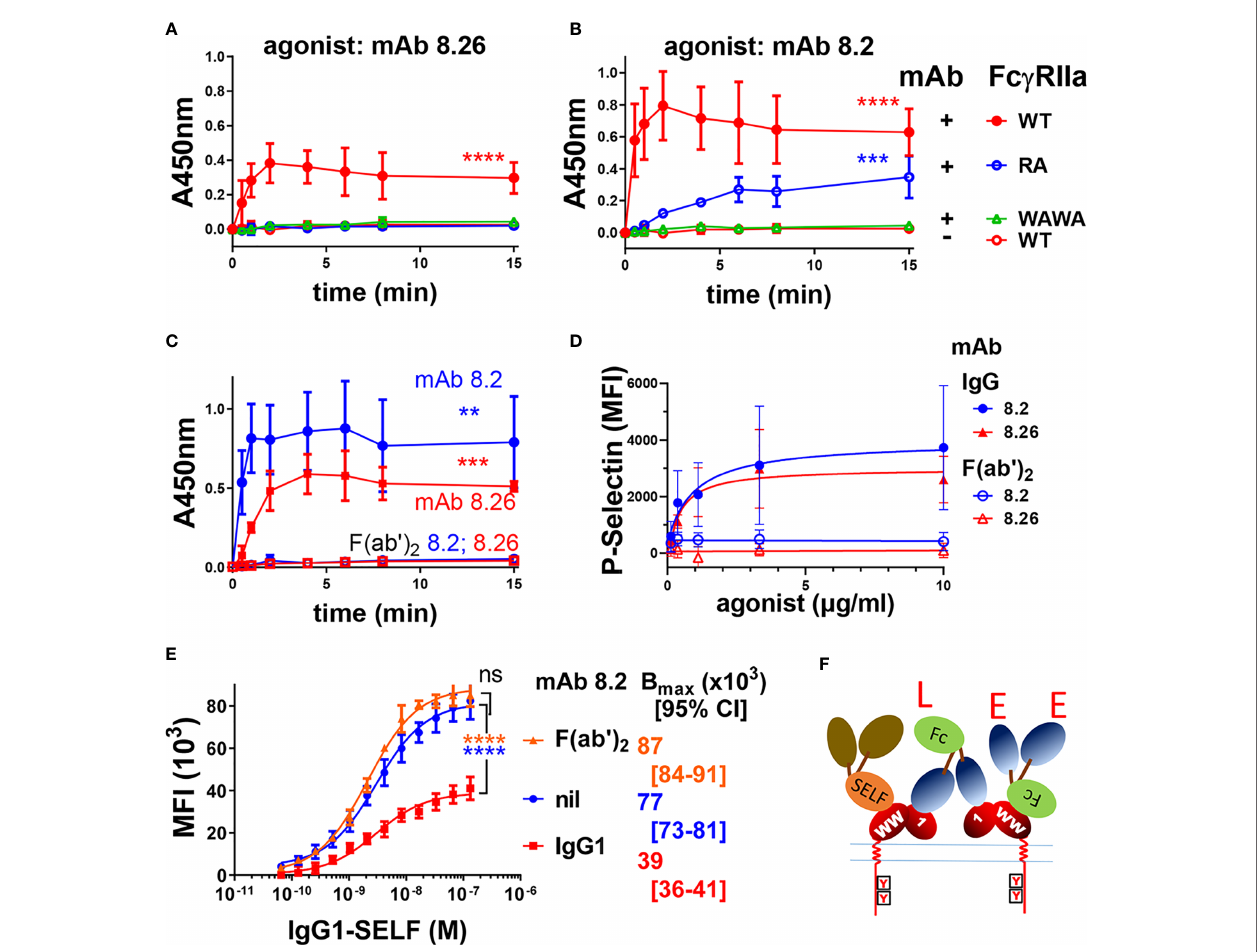
FIGURE 4 | Fc g RIIa activation by anti-receptor mAbs requires both Fc : Fc g R binding function and an intact epitope with arginine at position 55. Intact mAbs induce receptor phosphorylation (A, B) of IIA1.6 cells expressing Fc g RIIa-WT, the Fc-binding inactive mutant Fc g RIIa-WAWA or the epitope inactive Fc g RIIa-RA (R55A) as indicated, were untreated (nil mAb) or stimulated with the intact mAbs (A) 8.26 or (B) 8.2. At the indicated times cell lysates were prepared and mAb IV-3 captured phospho-proteins were detected in the Fc g RIIa phosphorylation assay using with mAb 4.G10-biotin (n = 3 ± SD). (C) F(ab ’ ) 2 fragments of mAb 8.2 or 8.26 do not activate Fc g RIIa. Fc g RIIa phosphorylation ELISA, using Fc g RIIa (mAb 8.7) capture and IIA1.6 cells expressing Fc g RIIa-WT with treatment at the indicated times with either intact agonist mAb 8.2 or 8.26 (20 µg/ml) or their F(ab ’ ) 2 . (n = 3 ± SD). (D) Analysis of human platelet activation using the marker P-selectin by fl ow cytometry following the treatment of platelet rich plasma with mAb 8.2, mAb 8.26 or their (Fab) ’ 2 fragments (n = 3 ± SD, 2 individuals). Representative fl ow cytometry histograms are presented in Supplementary Figure 5 . (E) MAb 8.2 Fc engagement competitively inhibits half of the ligand binding sites on Fc g RIIa expressing cells. IIA1.6 cells expressing the R131 allelic variant Fc g RIIa-R131 were untreated or treated with mAb 8.2 (n = 3 ± SD) or its F(ab ’ ) 2 (n = 2 ± SD) (10 µg/ml) followed by the indicated concentrations of the high af fi nity ligand, (anti-TNP chimeric) human IgG1-SELF. The binding of the monomeric IgG1-SELF was detected with